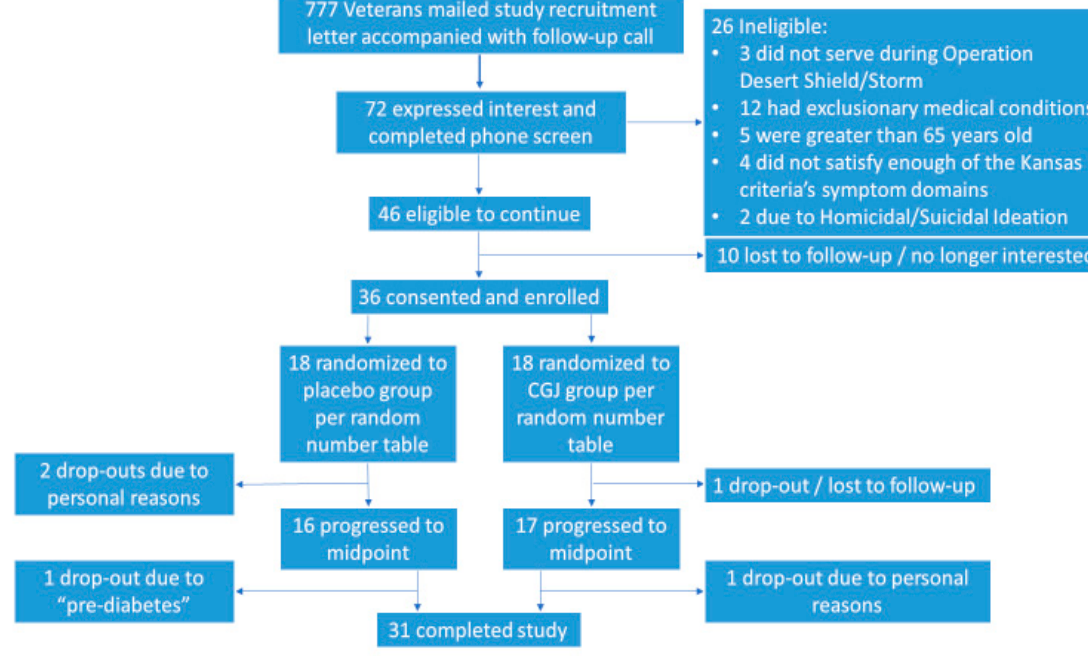
Figure 2. Subject selection and group assignment based on study design. CGJ—Concord grape juice.